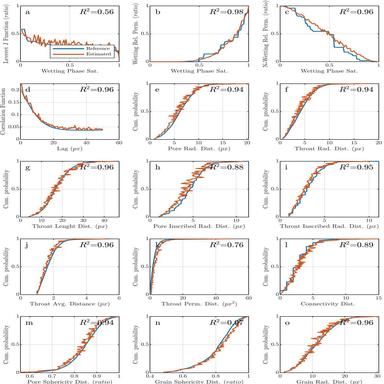
Example comparison of the reference and estimated values of 15 functions and distribution for one of the image samples in the dataset (sample #1). The average correlation coefficient of the reference and estimated curves is 0.9616.